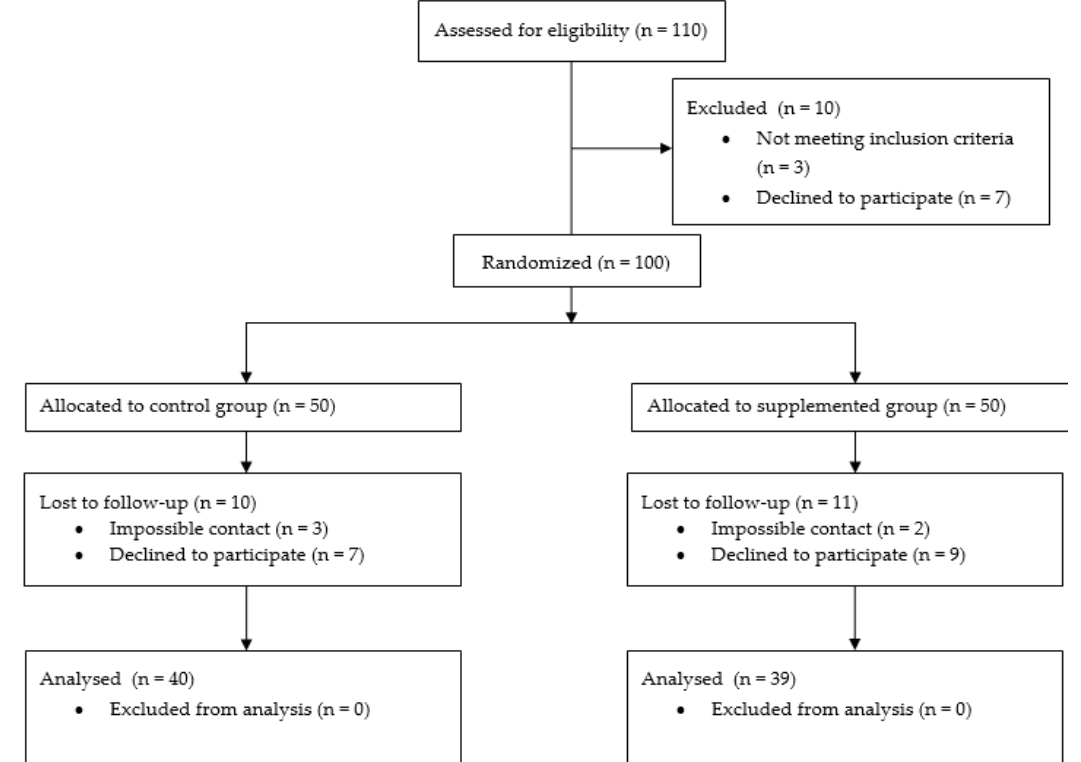
Figure 1. Consolidated Standards of Reporting Trials flow diagram (CONSORT).